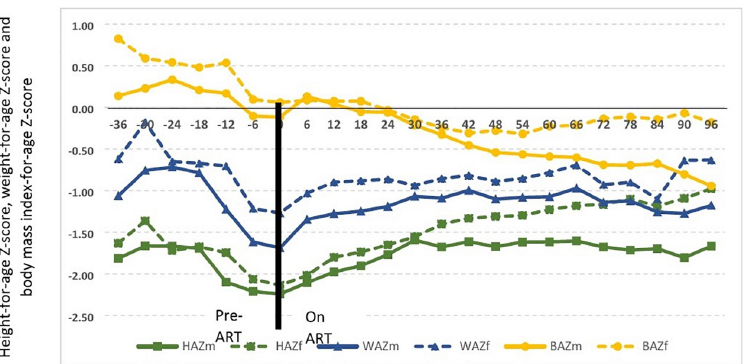
Fig 1. Growth evolution over time before and after initiation of antiretroviral therapy using age-standardized Z- scores for height, weight and body mass index. Abbreviations : ART = Antiretroviral therapy, HAZ = Height-for-age Z-score (HAZm = males; HAZf = females), WAZ = Weight-for-age Z-score (WAZm = males; WAZf = females), BAZ = body mass index-for-age Z-score (BAZm = males; BAZf = females).